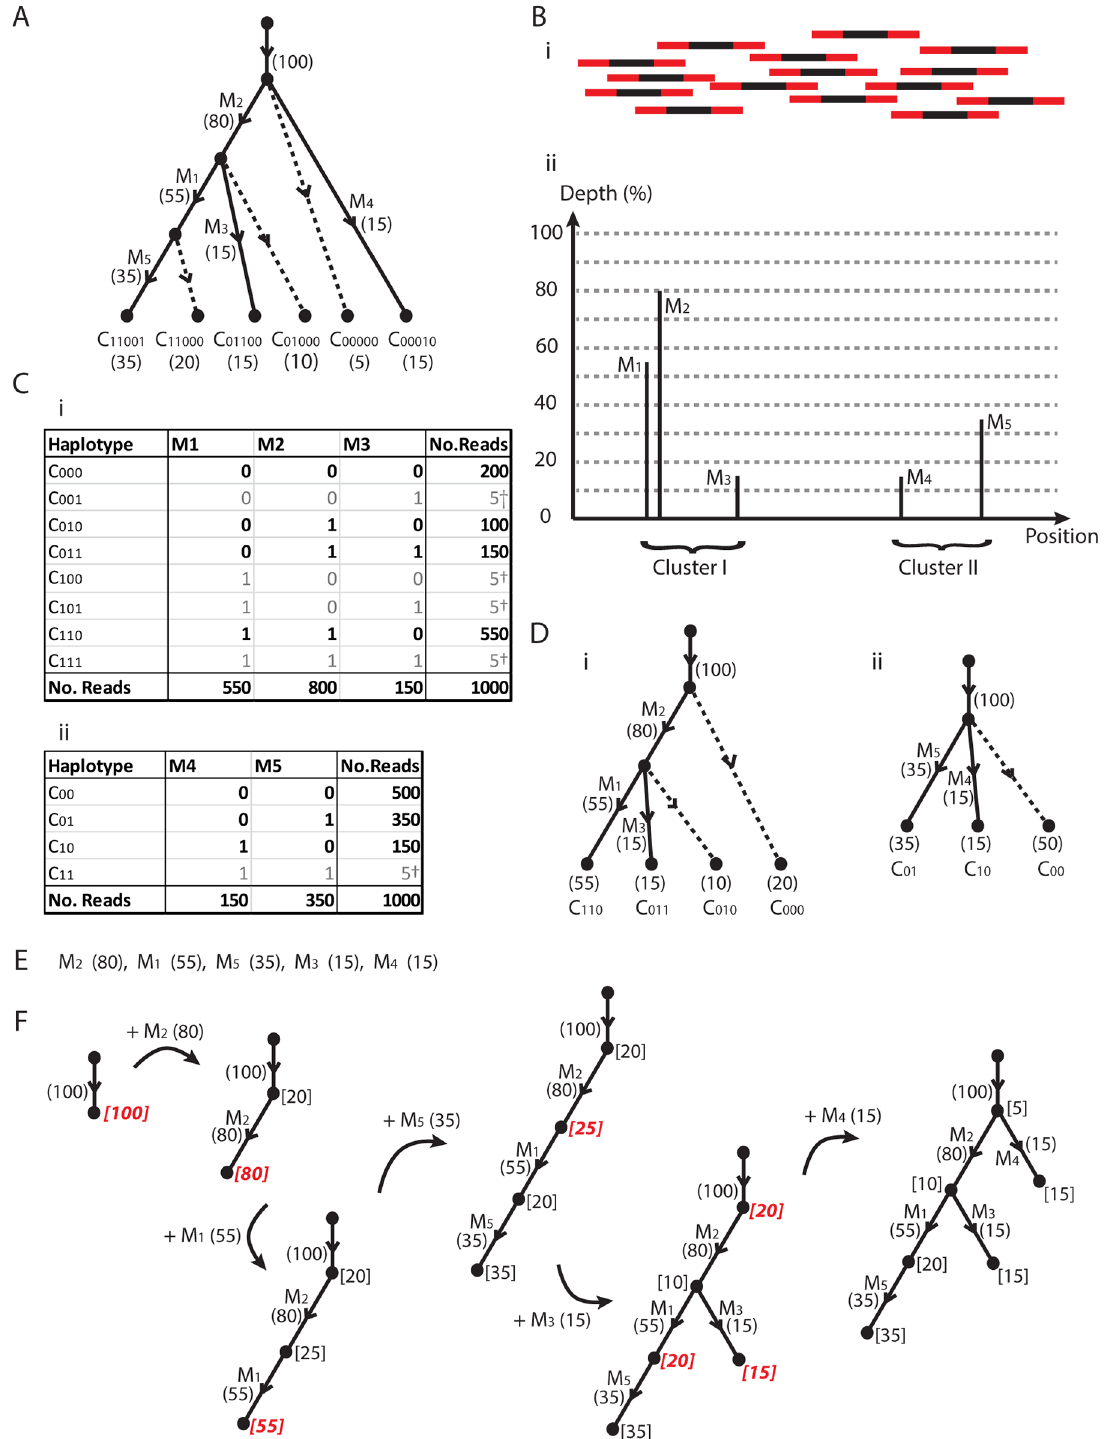
Fig 2. A super-tree sample. (A) A contrived evolution of a mixed viral population involving five mutations and six clones. Dotted lines indicate internal nodes extended to a leaf. (B) A notional representation of sequencing across the region of interest, and the resulting Depth-Position graph. Paired reads bridge two clusters of mutations. (C) Read count data obtained for the two clusters, with total depth x1000, along with artifacts † . (D) Evolutionary trees corresponding to (Ci,ii). (E) Ordered list of mutations and population prevalences (%). (F) Reconstruction of original tree in (A).